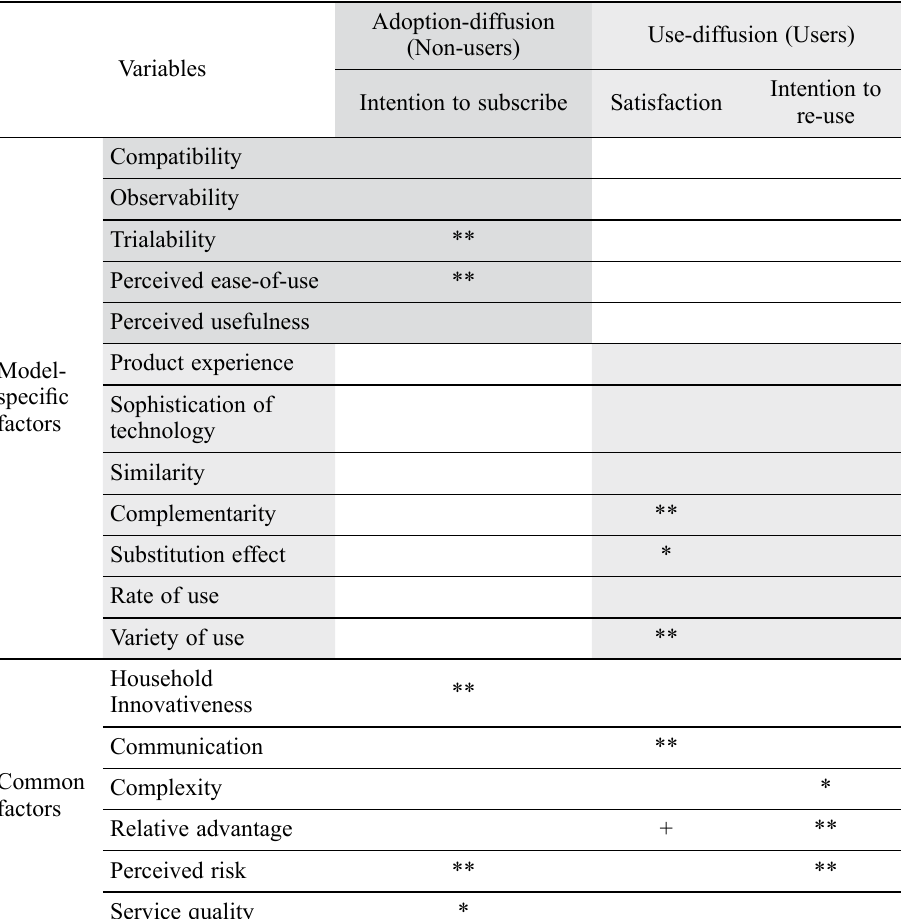
Table 5. Summary of